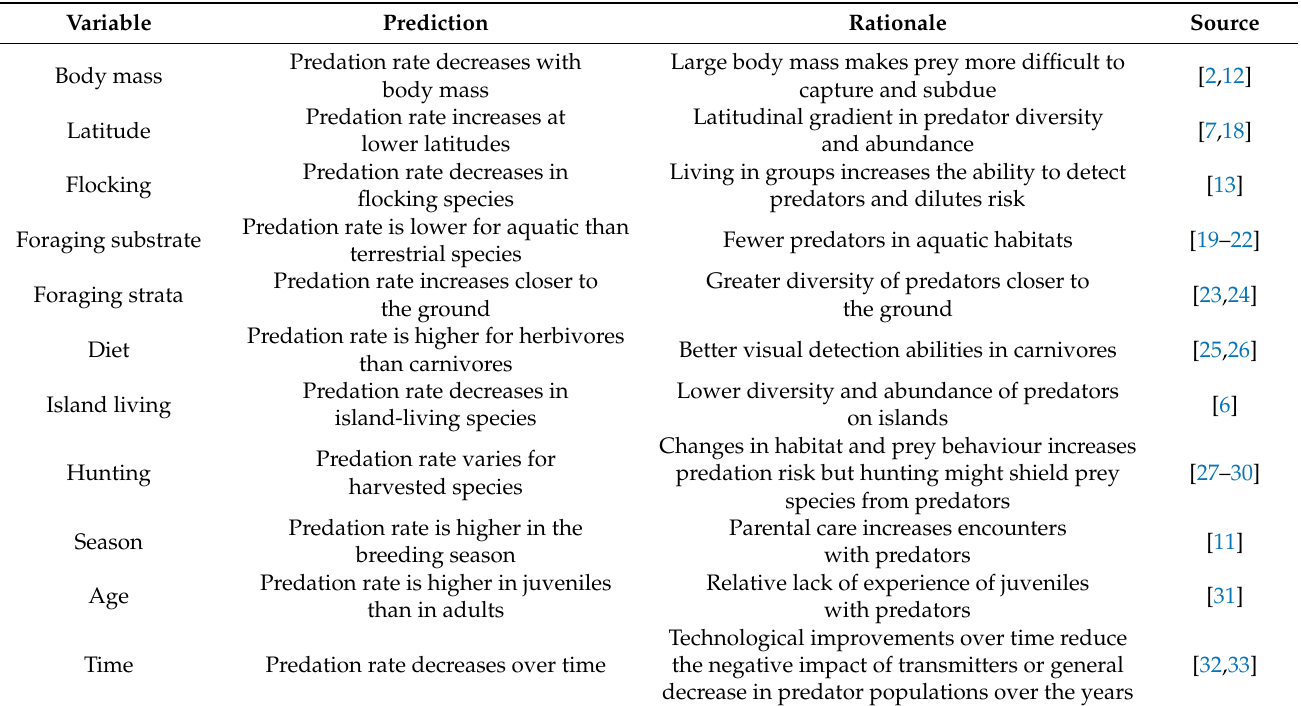
Table 1. Predictions and rationale for variables included as predictors of predation rate in